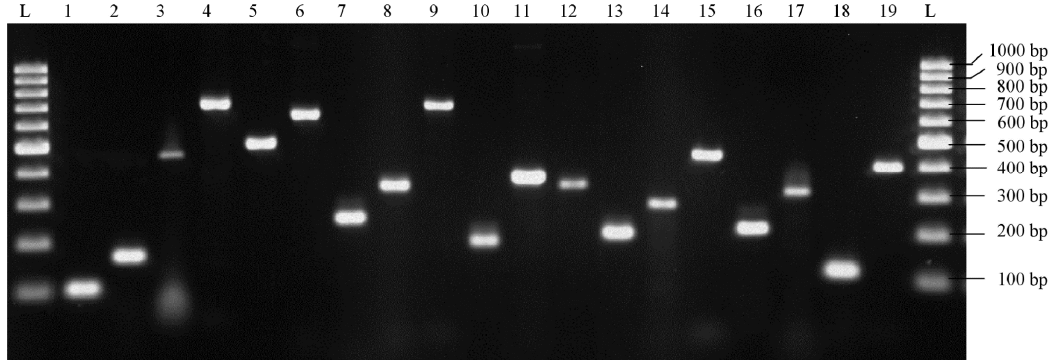
Figure 1. Gel electrophoresis of amplified virulence gene products from food isolates. Lane L: 100 bp molecular weight marker; lane 1: sea (102 bp); lane 2: seb (164 bp); lanes 3: sec (451 bp); lane 4: seg (704 bp); lane 5: seh (495 bp); lane 6: sei (630 bp); lane 7: sel (240 bp); lane 8: sem (326 bp); lane 9: